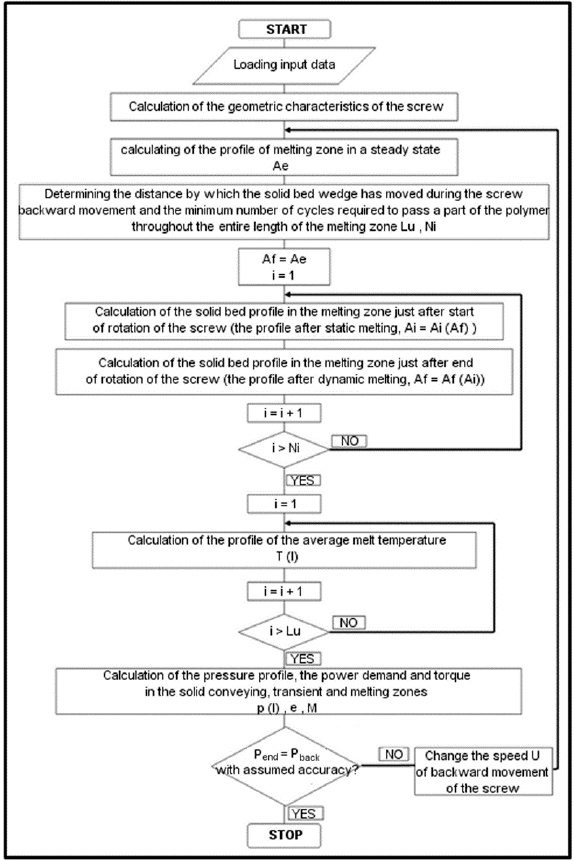
Figure 2. The algorithm of the computer program, based on the presented model.